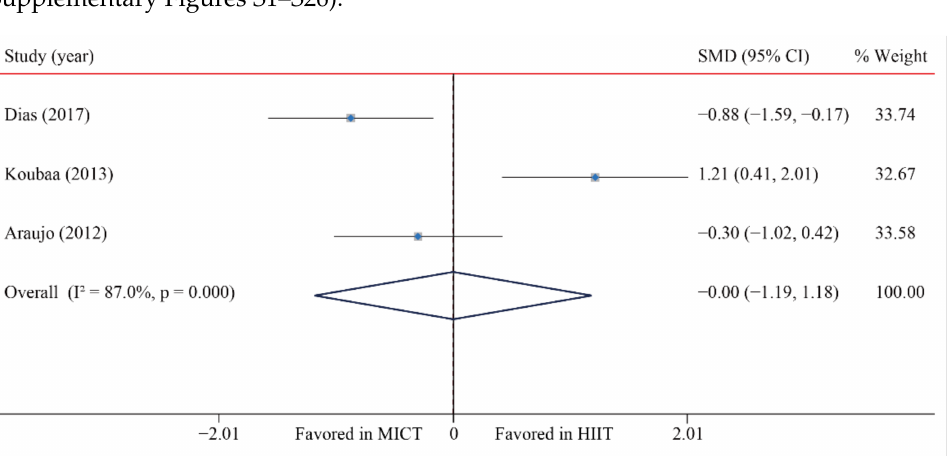
Figure 13. Effect of HIIT versus MICT on low-density lipoprotein